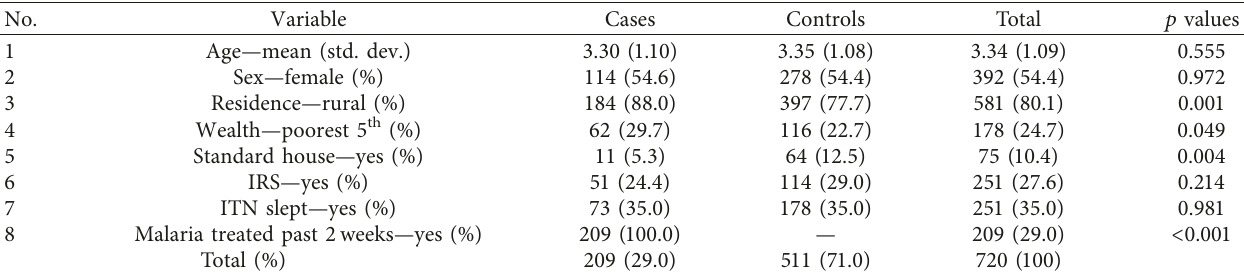
Table 2: Basic characteristics of the cases and controls.